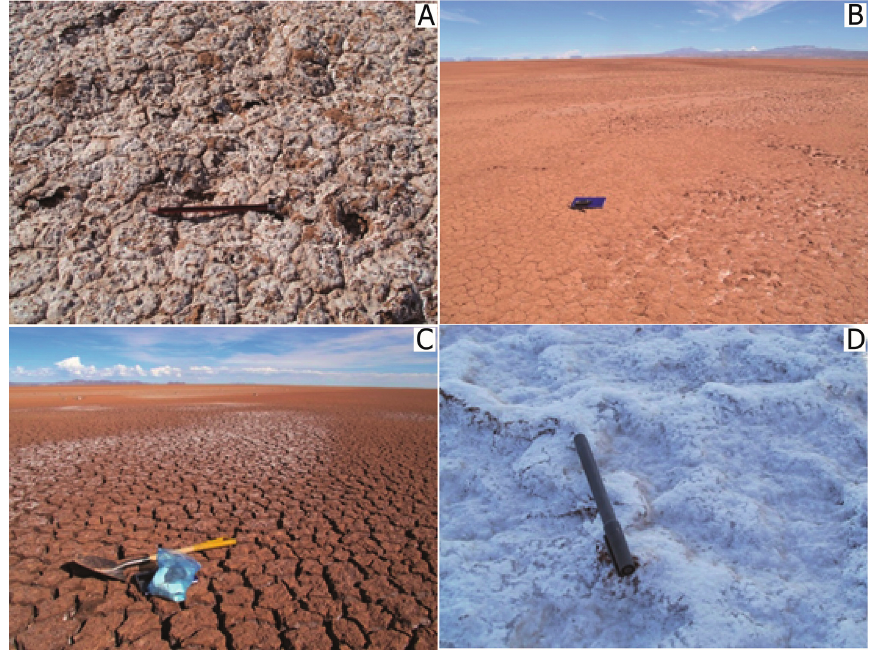
Figure 5. Different types of surface materials in various locations in the river terminus on 11-Nov-2012. ( A ) Mixture of salt and sediment (salty surface); ( B ) Silt-rich surface; ( C ) Clay-rich surface; ( D ) Thick salt crust (pure salt). The locations for each surface type are indicated on Figure